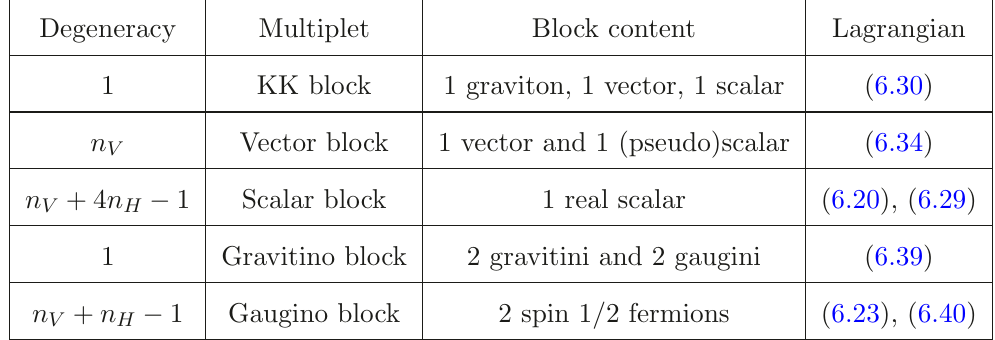
Table 6 . Decoupled fluctuations in = 2 SUGRA around the KK black hole with constant N dilaton. The decoupling in the bosonic sector holds for an arbitrary prepotential. The fermionic sector has been further decoupled by specializing to the ST ( n )